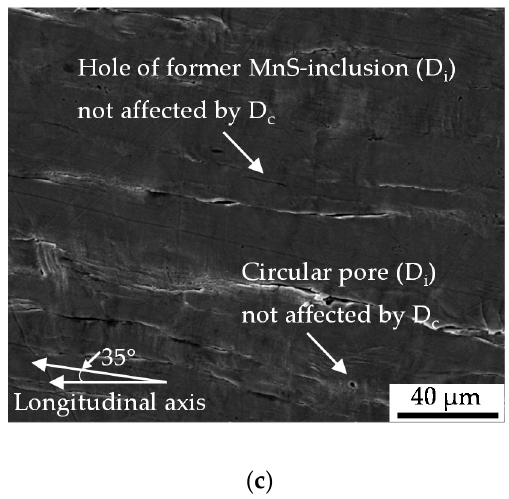
Figure 7. Stages of cyclic damage (D c ) evolution ( a ) early stages; ( b ) advanced stages; ( c ) with initial forming induced damage (D i ).